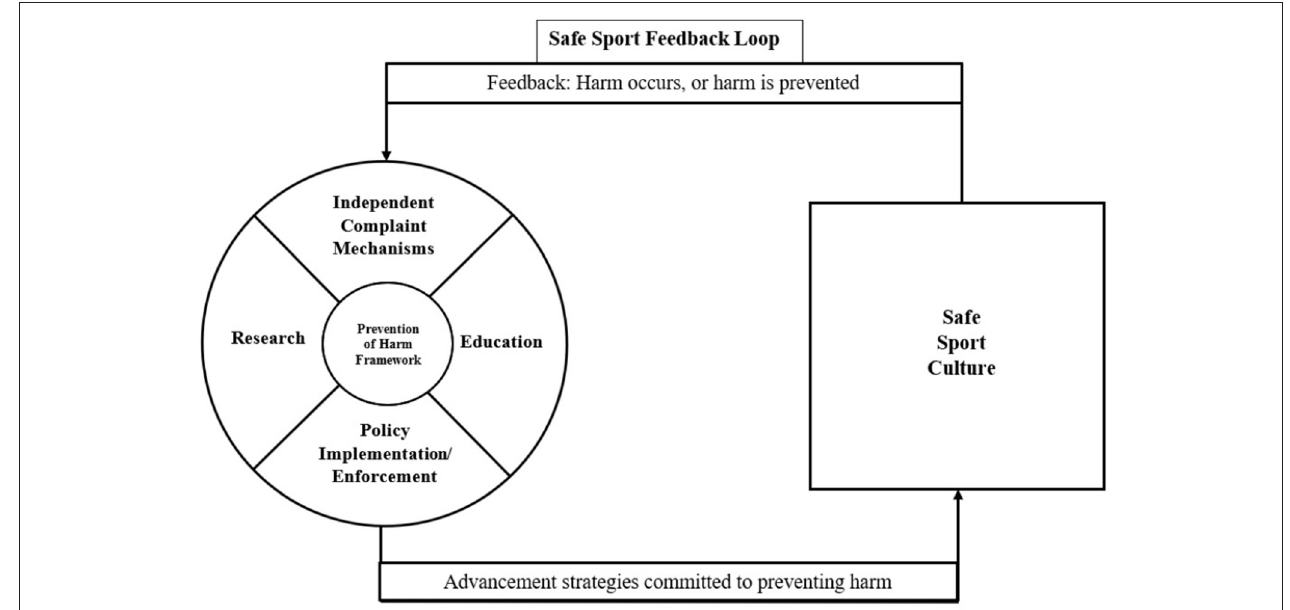
FIGURE 1 | Prevention of harm framework for safe